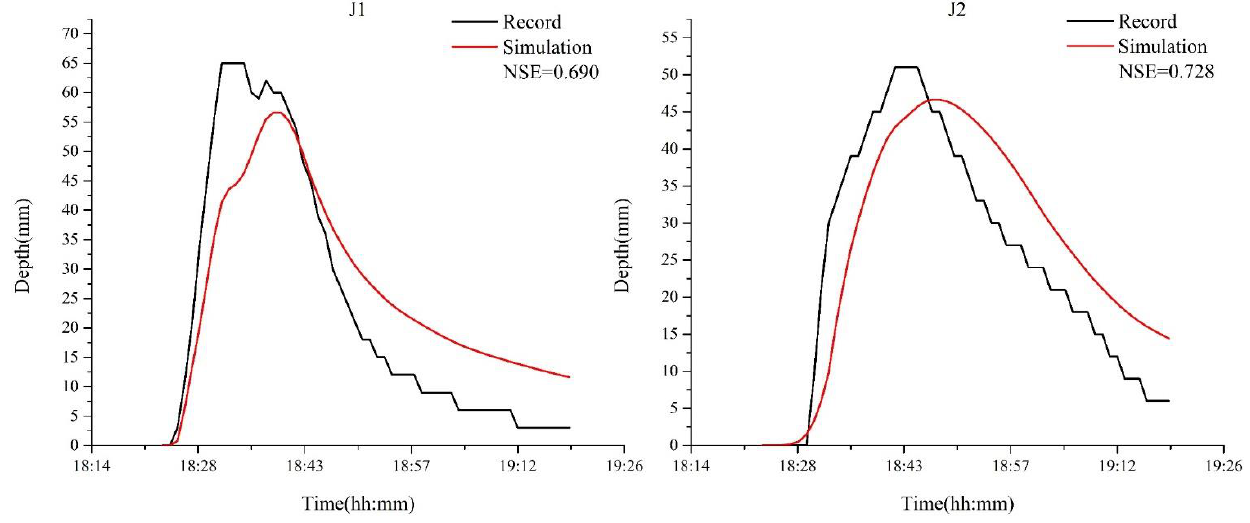
Figure 4. Calibrated junction water depths (J1 and J2).